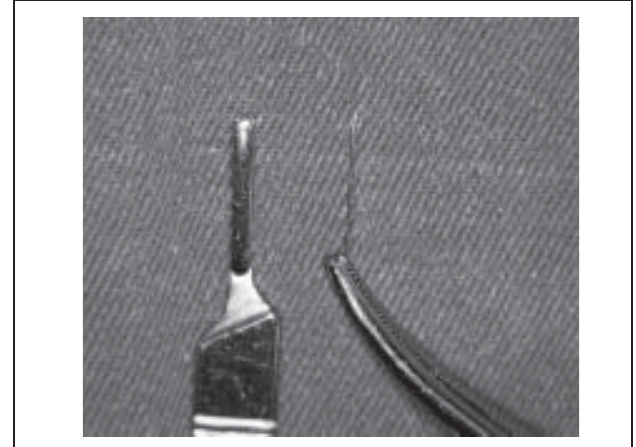
Figure 3. Retrieved broken